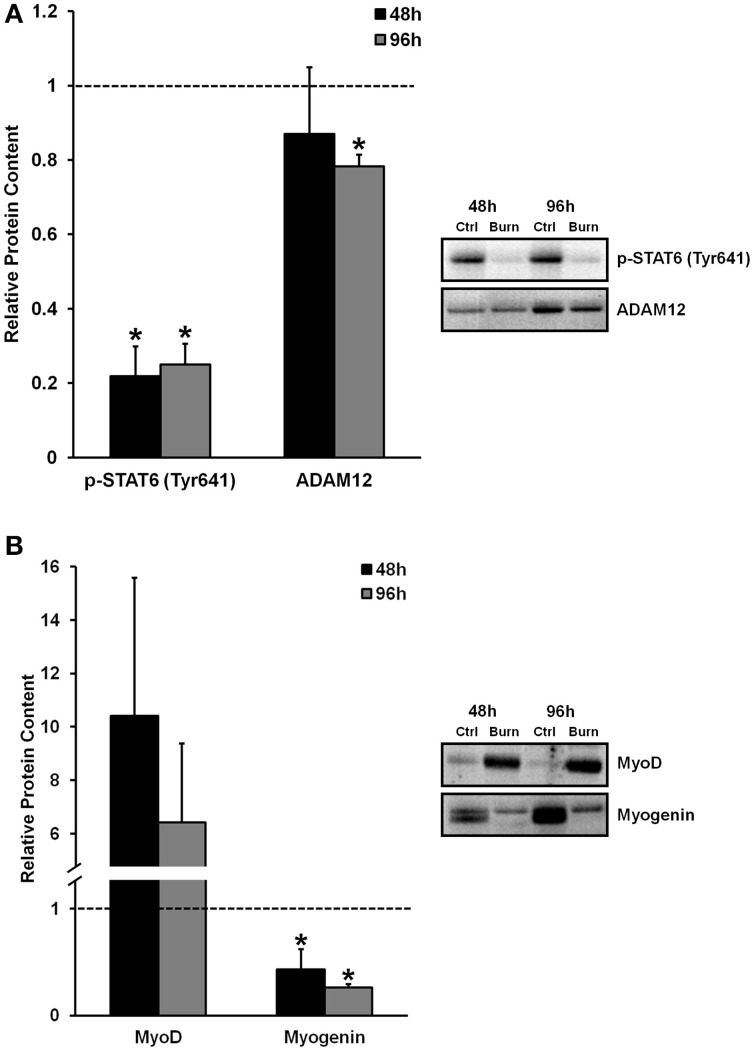
Effects of burn serum on markers of myogenic fusion (A) and myogenic differentiation (B). *Different from control at respective time point; P < 0.05. Dotted line represents control values.